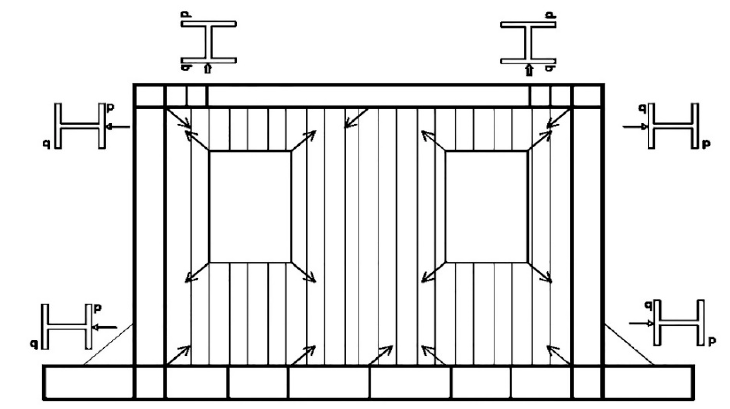
Figure 9. Location of strain gauges used during the test of specimen